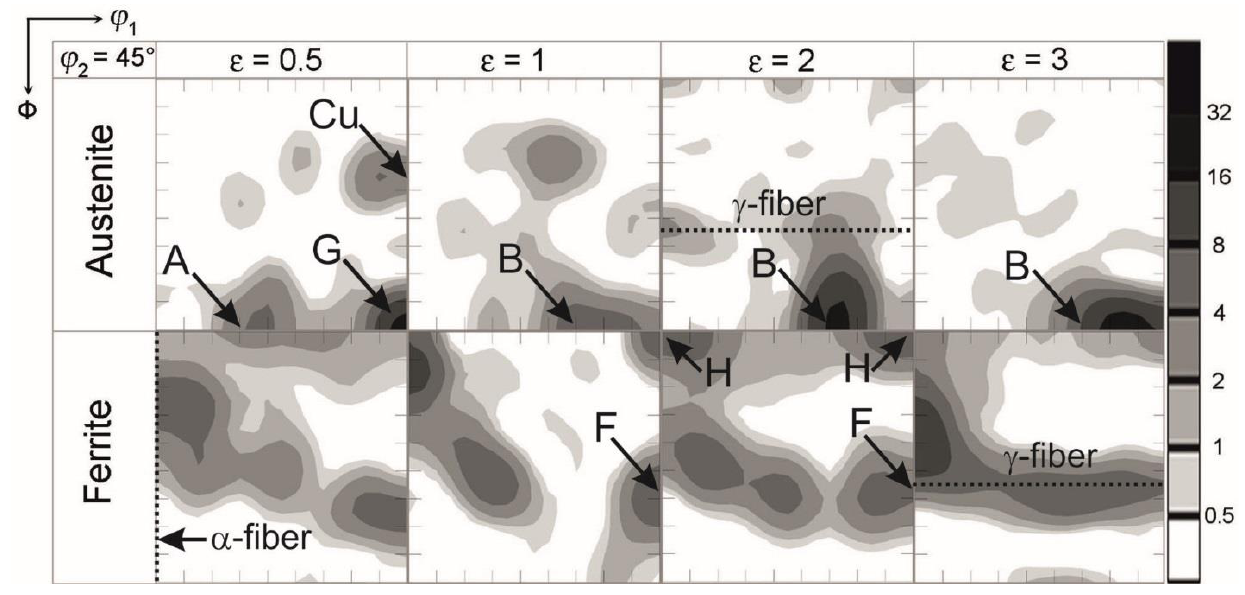
Figure 16. Orientation distribution functions at φ 2 = 45° for a 304L stainless steel cold rolled to the indicated total strains.